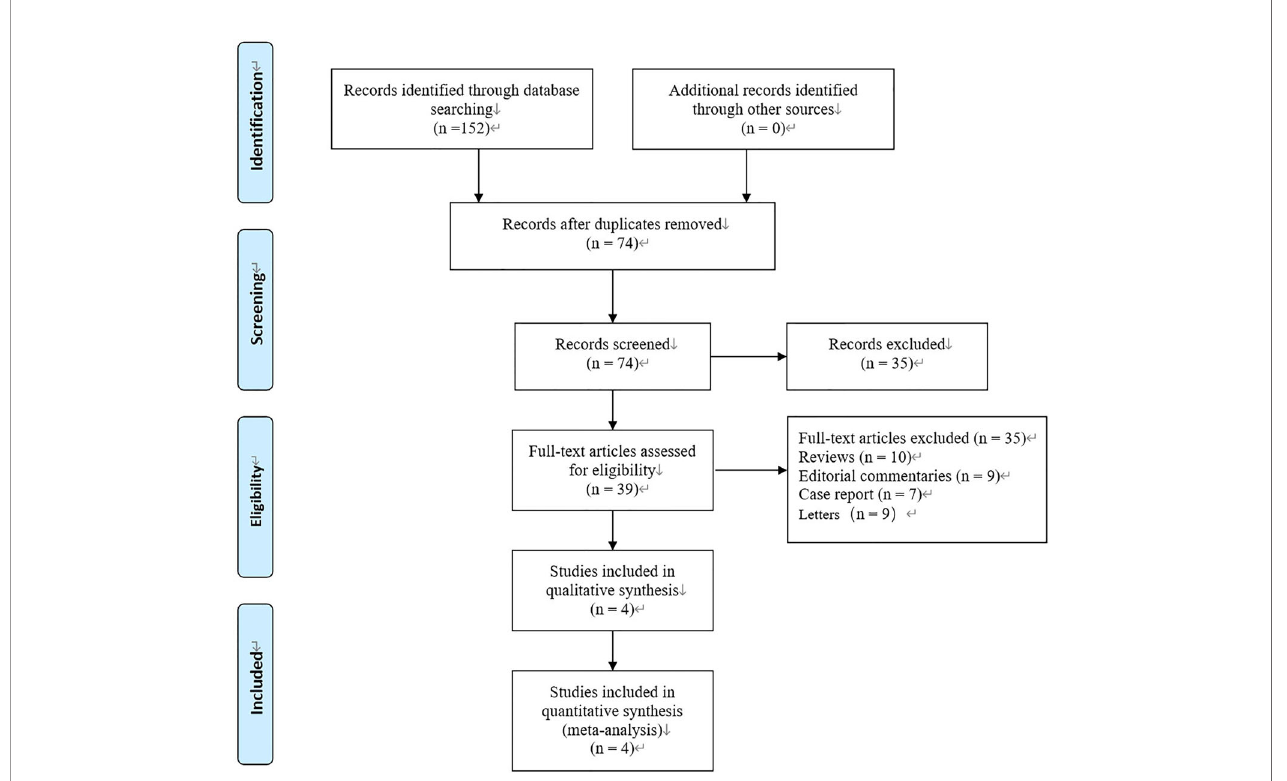
FIGURE 1 | Flow diagram of studies identi fi ed, included, and excluded.